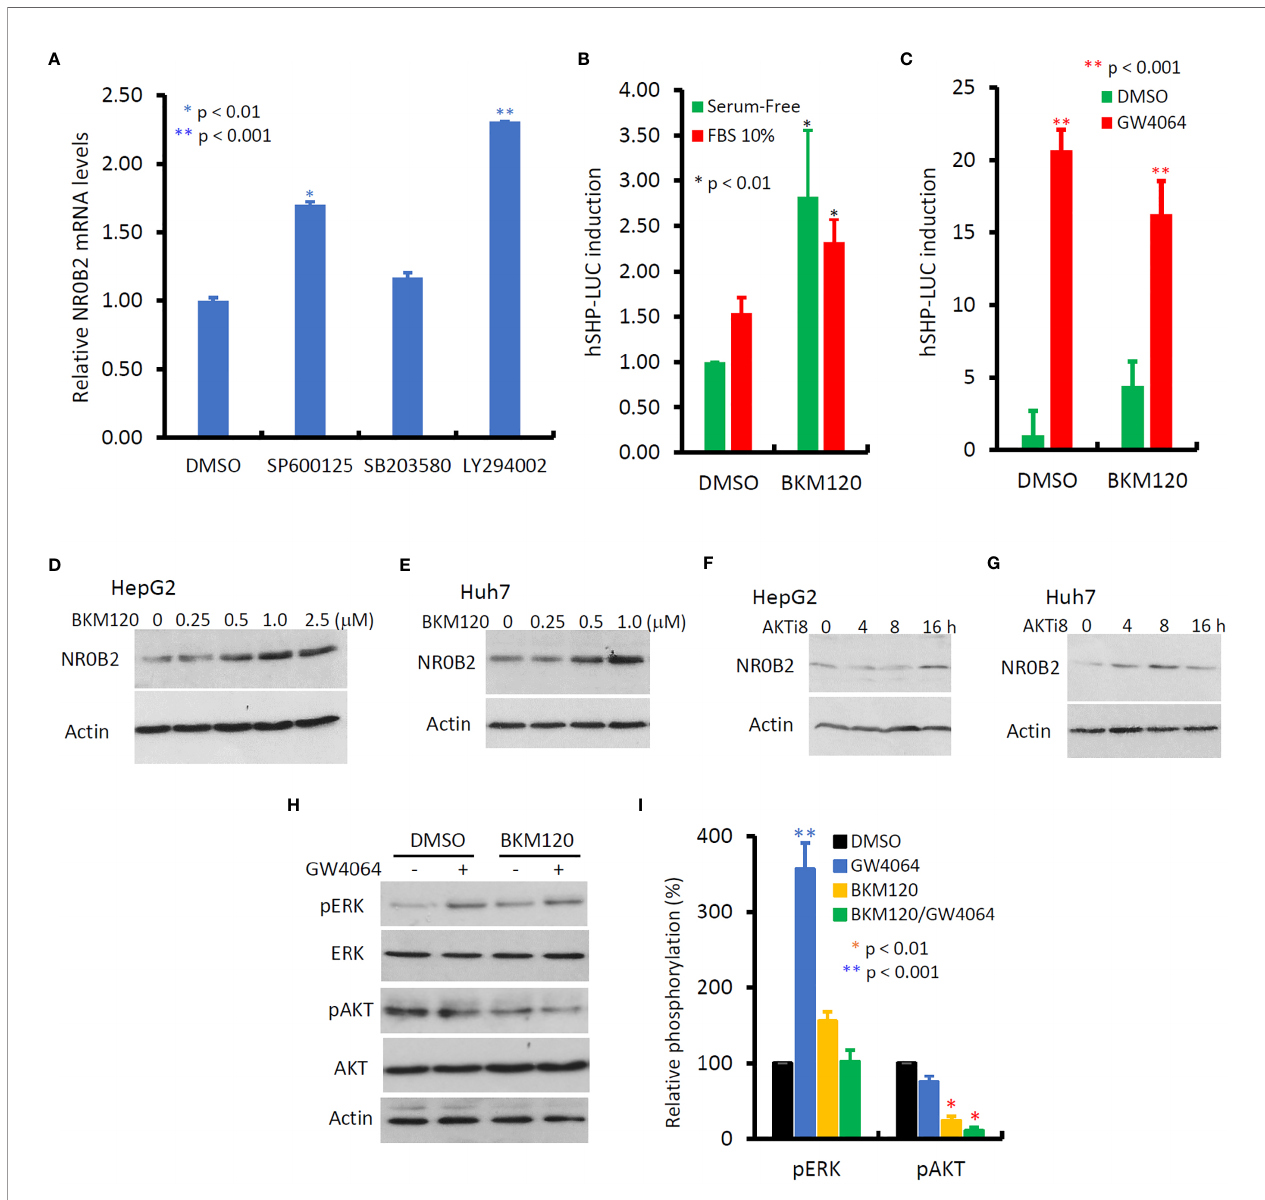
FIGURE 6 | Inhibition of PI3K activity enhances NR0B2 gene expression in HCC cells. (A) HepG2 cells were treated with DMSO or JNK inhibitor SP600125 (50 m M), p38MAPK inhibitor SB203582 (10 m M), and PI3K inhibitor LY294002 (50 m M) for 24 h. Total RNAs were extracted for qPCR assays. The relative expression levels of NR0B2 gene expression are calculated against the DMSO treatment (set as 1.0). Error bar indicates the SEM from three independent experiments. The asterisk indicates a signi fi cant difference compared to the DMSO control (Student t -test). (B) HepG2 cells were seeded in 6-well plates and then transfected with human NR0B2 promoter-driven luciferase reporter construct (hSHP-LUC, 0.5 m g DNA/well). After serum starvation overnight, cells were pre-treated with PI3K inhibitor BKM120 (10 m M) for 30 min and then cultured with serum-free or 10% FBS for 24 h. Luciferase assay was carried out as described in our publication (14, 15). The relative reporter activity was calculated against the DMSO control (set as 1). Error bar indicates the SEM from three independent experiments. The asterisk indicates a signi fi cant difference compared to the DMSO control (Student t -test). (C) HepG2 cells were seeded in 6-well plates and then transfected with human NR0B2 promoter-driven luciferase reporter construct (hSHP-LUC, 0.5 m g DNA/well). After pretreatment with BKM120 (10 m M) for 30 min, cells were stimulated with GW4064 (5 m M) for 24 h. Luciferase assay was carried out as described earlier. (D – G) HepG2 or Huh7 cells were treated with DMSO, BKM120 for 24 h at the indicated concentrations or AKT inhibitor 8 (AKTi8, 10 m M) for the indicated period. Cells were harvested for western blot assays with the antibodies as indicated. (H, I) HepG2 cells were pre-treated with BKM120 (10 m M) for 30 min, followed by GW4064 (5 m M) stimulation for 24 h. Cells were harvested for western blot assays with the antibodies as indicated. Band density for phosphorylated ERK or AKT were normalized against total ERK or AKT, respectively. Each treatment ’ s relative density was calculated against the DMSO control (set as 100%) individually and then plotted as a bar graph. Data represent three independent experiments. The asterisk indicates a signi fi cant difference compared to the DMSO control (Student t